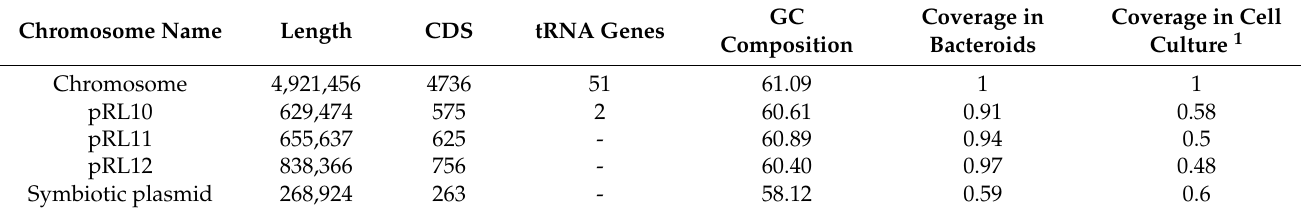
Table 1. Statistics for the genome assembly and annotation of the strain